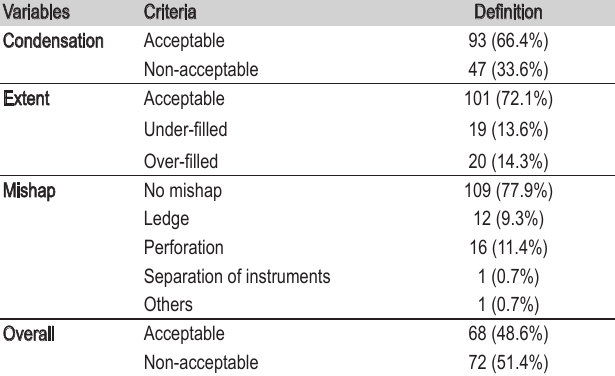
Table 3 - Acceptable and non-acceptable root canal fillings performed by undergraduate students.